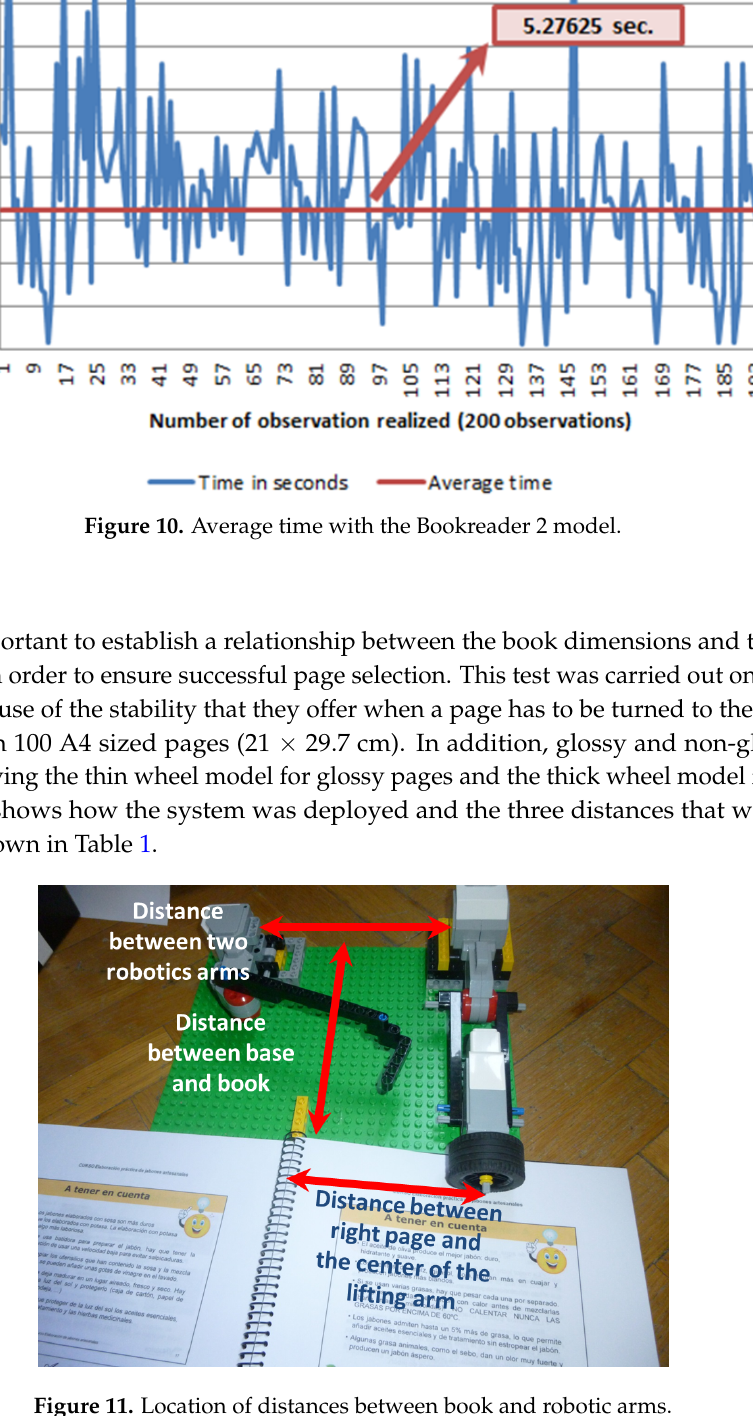
Figure 11. Location of distances between book and robotic